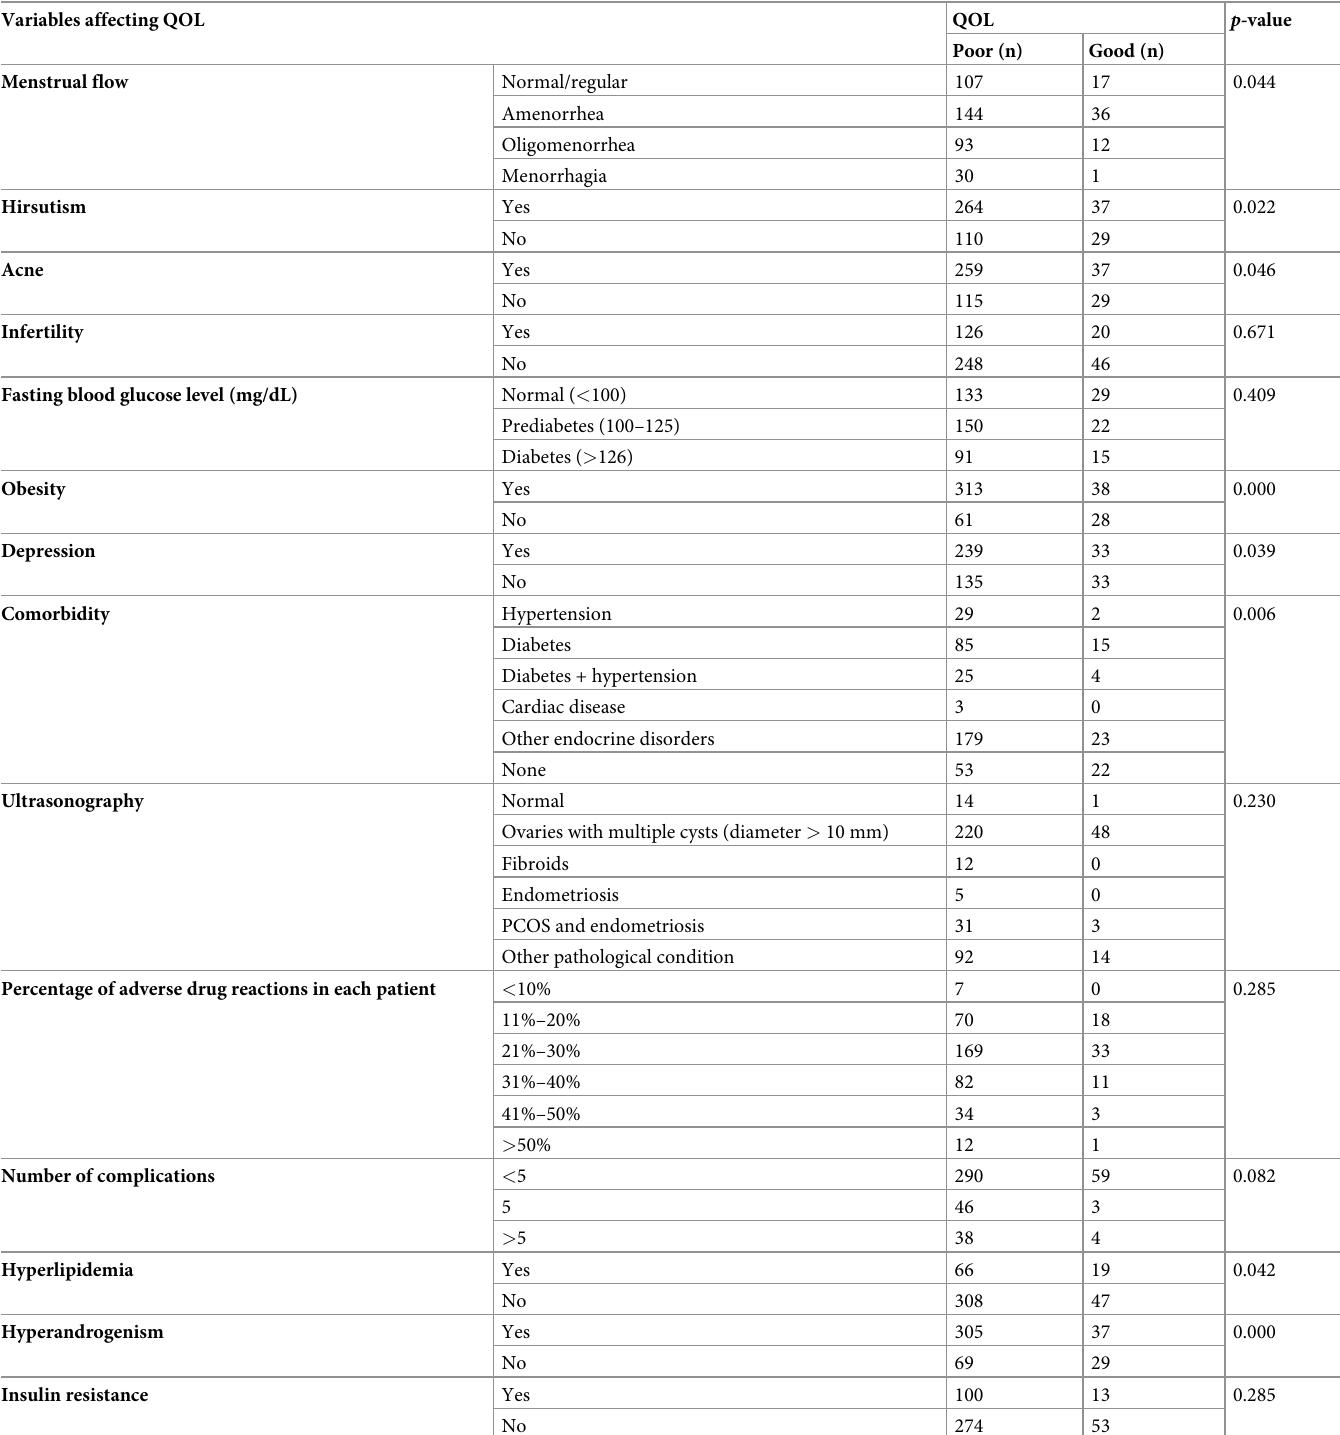
Table 4. Cross-tabulation of various factors affecting